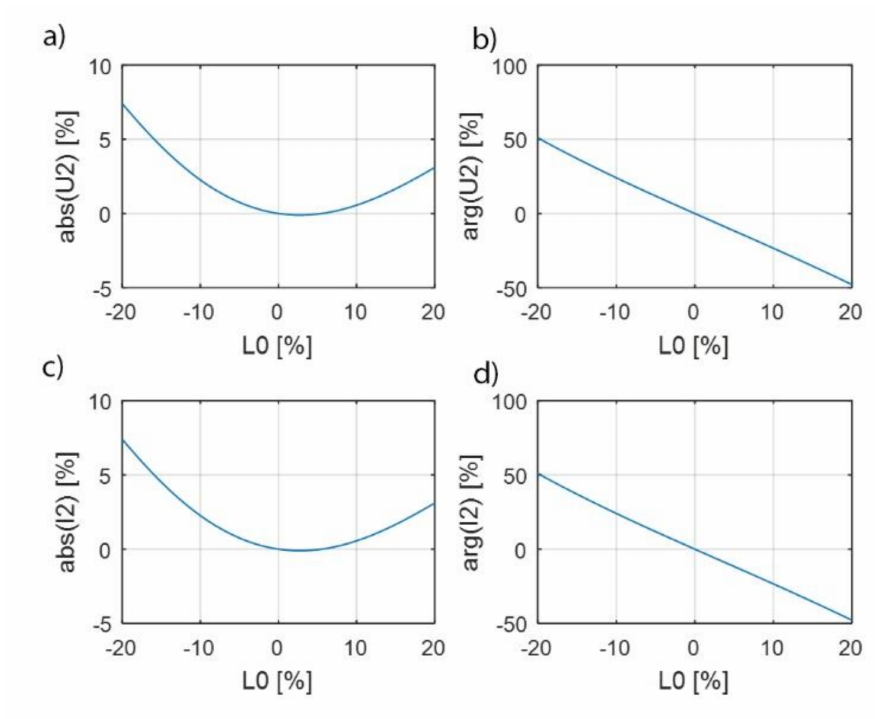
Figure 18. Changes of wave parameters depending on L 0 at f = 500 kHz; ( a ) U 2 voltage modulus, ( b ) U 2 argument, ( c ) I 2 modulus, ( d ) I 2